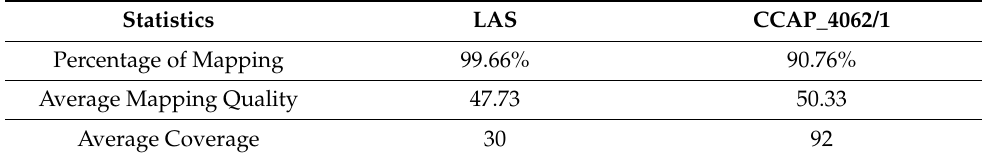
Table A5. Statistics of mapping LAS and CCAP_4062/1 PacBio long reads against the CCAP_4062/1 genome